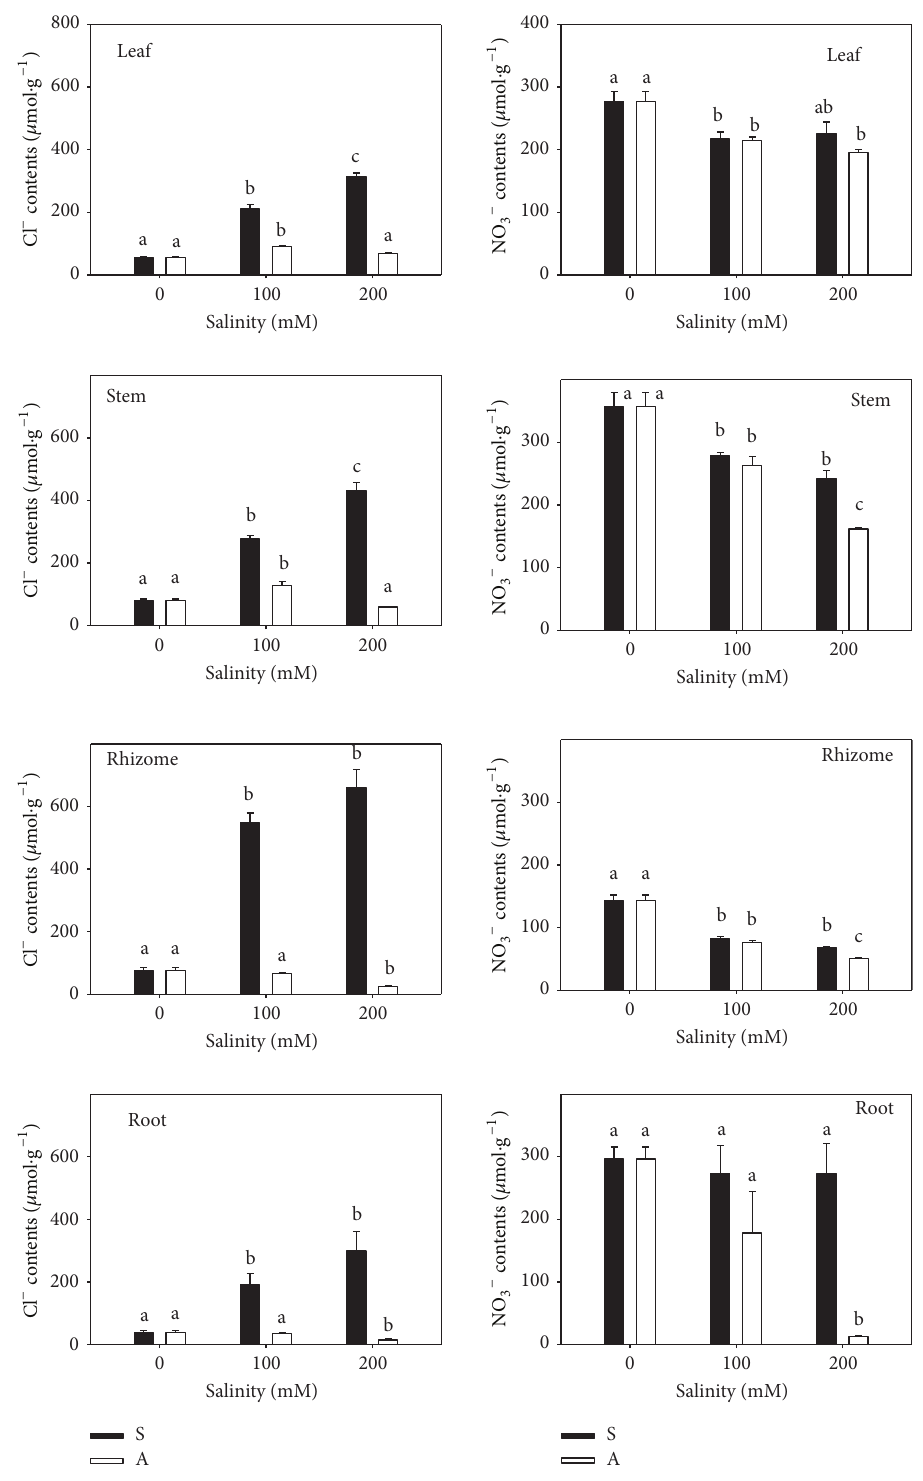
Figure 4: The Cl − and NO 3− contents. The effects of salt stress (S) and alkali stress (A) on the Cl − and NO 3− content in rhizomes, stems, roots, and leaves of L. chinensis . There are three levels under both stresses: 0, 100, and 200 mmol/L. The means and standard errors are reported. Within each column, the different letters indicate significant difference among treatments ( 𝑃 < 0.05